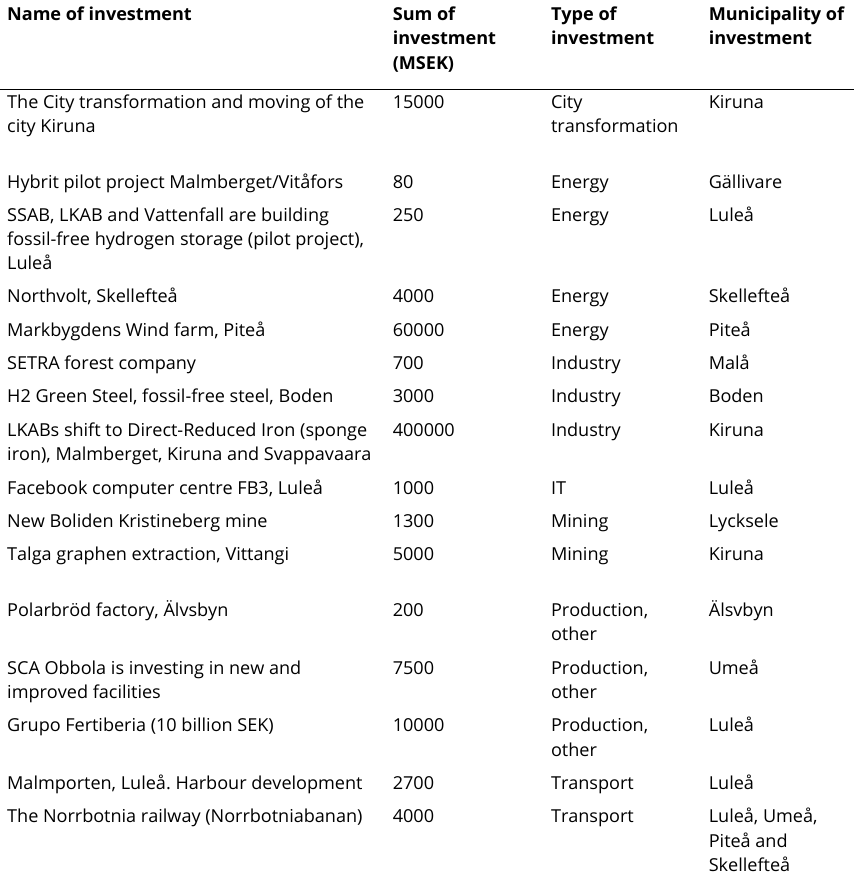
Table 2. Summary of investments in Sweden’s Norrbotten and Västerbotten Counties. Large-scale projects already planned and/or decided. Sums are estimates based on available statistics on their respective web